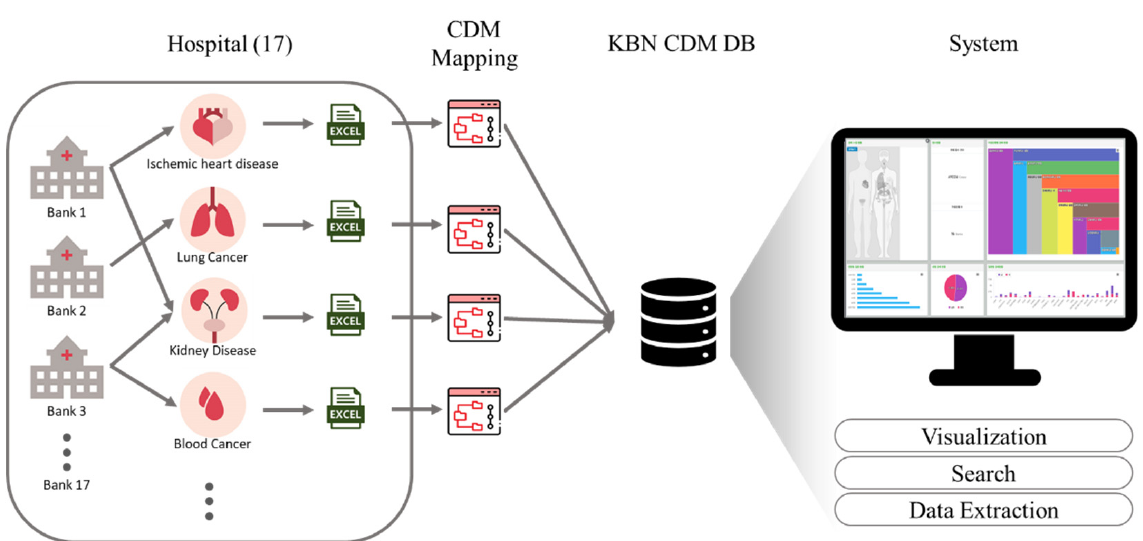
Figure 2. KBN clinical information management system.